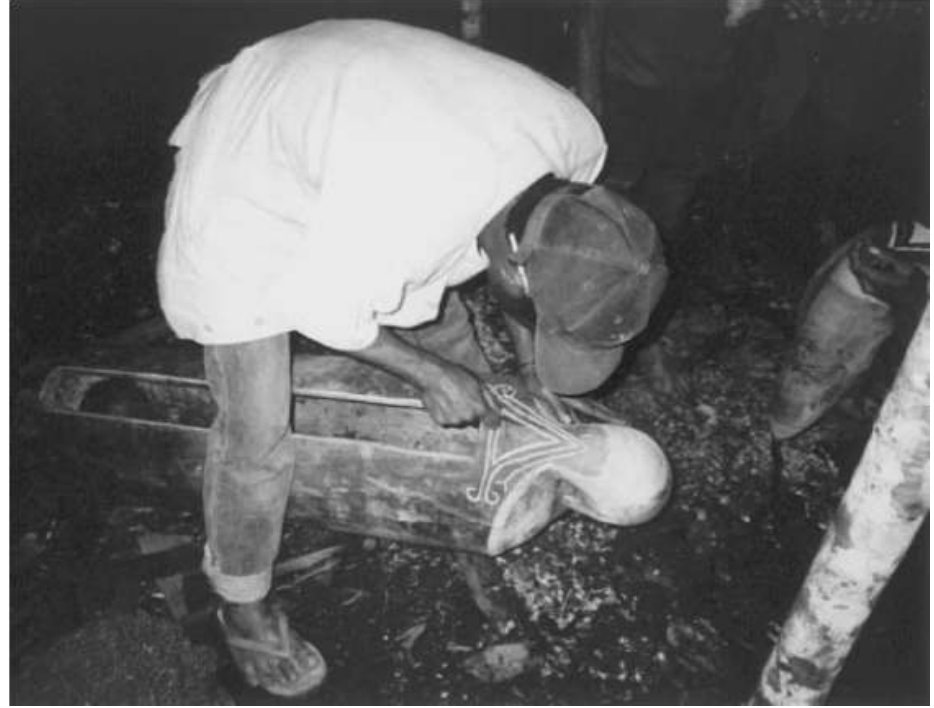
Figure 4: Photo: J.